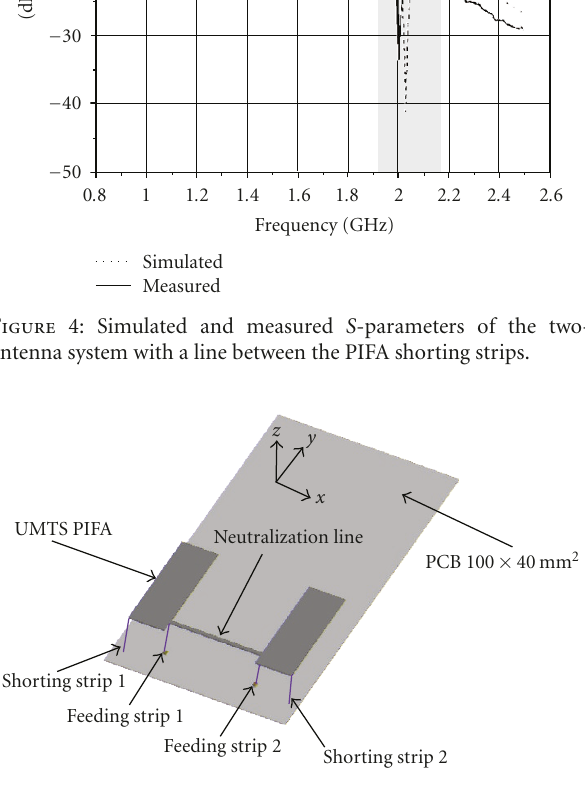
Figure 5: 3D view of the two-antenna system with a suspended line between the PIFA feeding strips.